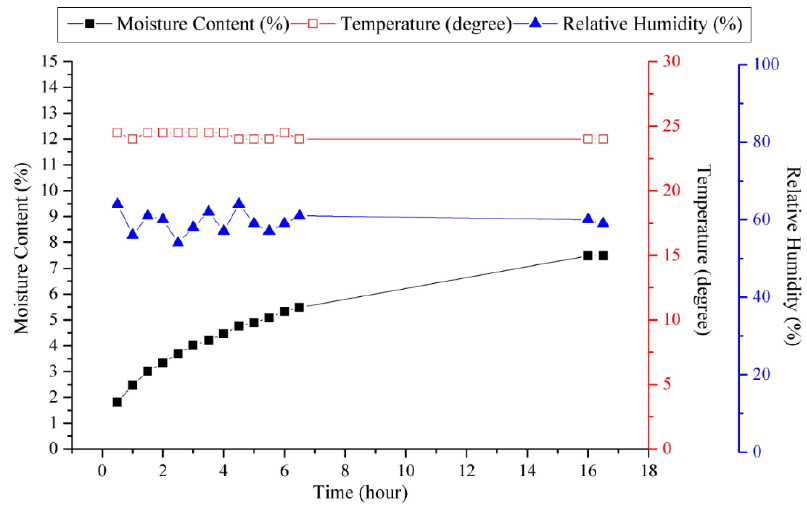
Figure 20. The moisture absorbing ability of pre ‐ processed insulation paper.